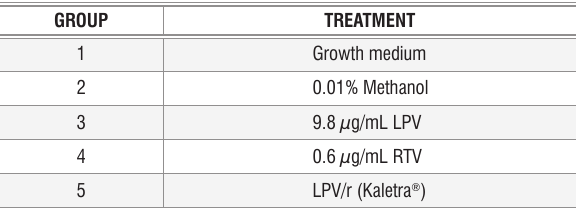
Treatment groups and drug concentrations administered for each cell